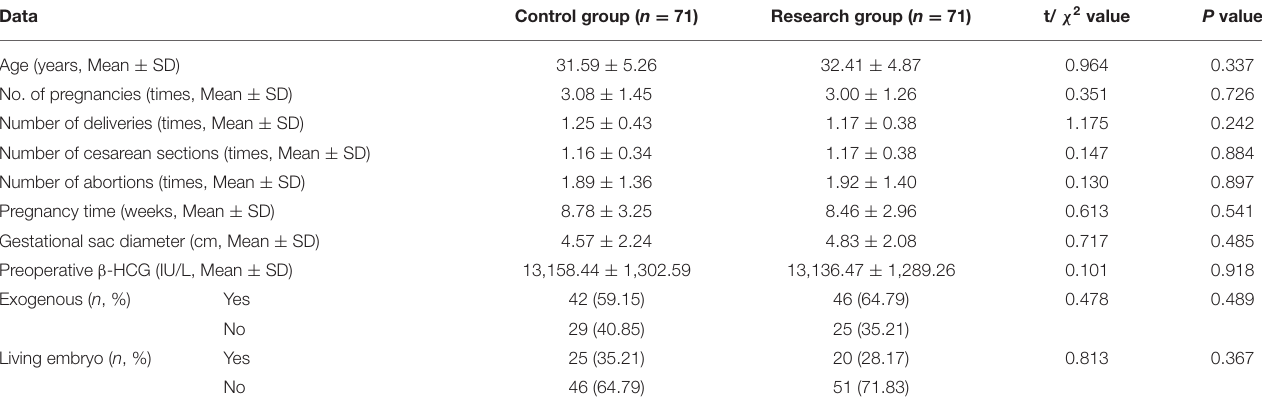
TABLE 1 | Comparison of baseline demographic information between the two groups of